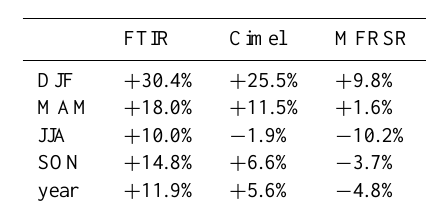
Fig. 7. Time series of the difference between FTIR and the other techniques ( 2 given in the panels, respectively. Clear sky bias in PWV of FTIR, Cimel and MFRSR observations determined from RS92 measurements (expressed as 1 − PWV c ). PWV a FTIR